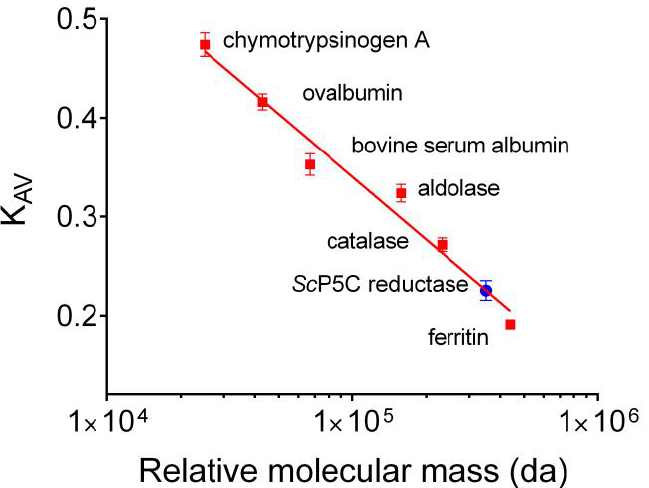
Figure 2. Relative molecular mass of yeast P5C reductase under native conditions. The retention pattern of the enzyme upon gel permeation chromatography on a Sephacryl S300 column was compared with that of molecular weight markers (Gel Filtration Calibration Kit, Pharmacia 17-0442-01 and 17-0441-01). Results are mean ± SD over 3 independent runs. Linear regression of K AV values plotted against the logarithm of the protein molecular mass allowed an estimate of 320 ± 15 kDa for yeast P5C reductase.